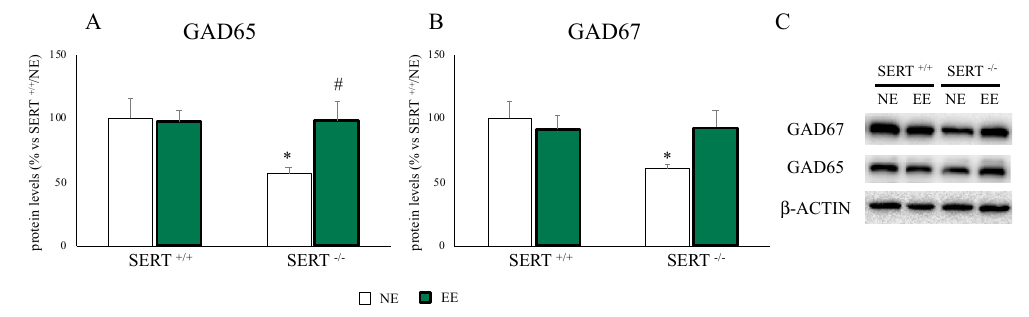
Figure 5. Analyses of GAD65 ( A ) and GAD67 ( B ) protein levels in the PFC of SERT +/+ and SERT − / − rats subjected to one month of exposure to NE (normal environment) or EE (environmental enrichment) and their representative western blot bands ( C ). The data are presented as percent change of SERT +/+ / NE and are expressed as mean ± standard error of the mean (SEM). * p < 0.05, vs. SERT +/+ / NE; # p < 0.05, vs. SERT − / − / NE two-way ANOVA with PLSD. Table 3. Analyses of Bdnf , spine, and GABAergic markers mRNA levels in the PFC of SERT +/+ and SERT − / − rats subjected to one month of exposure to NE or EE. The data are presented as percent change of SERT +/+ /NE and are expressed as mean ± standard error of the mean (SEM). * p < 0.05 vs. SERT +/+ /NE;